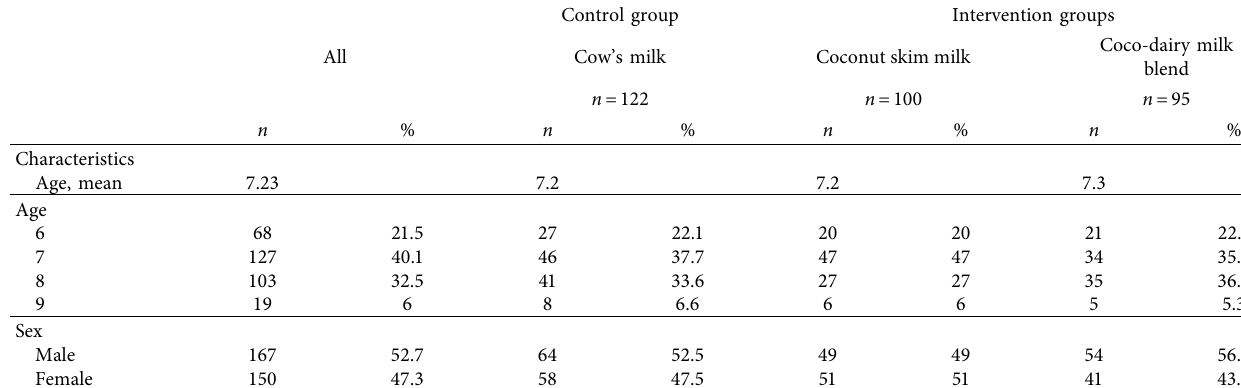
Table 3: Profile of child participants.